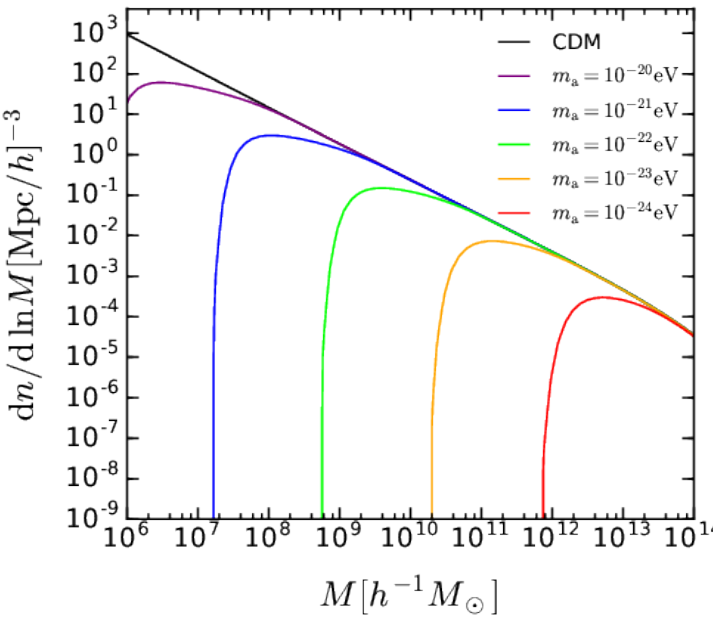
Figure 24. Dependence of the cut-off of the halo mass function on the mass of an FDM particle, and comparison with the CDM model. The figure is reproduced from